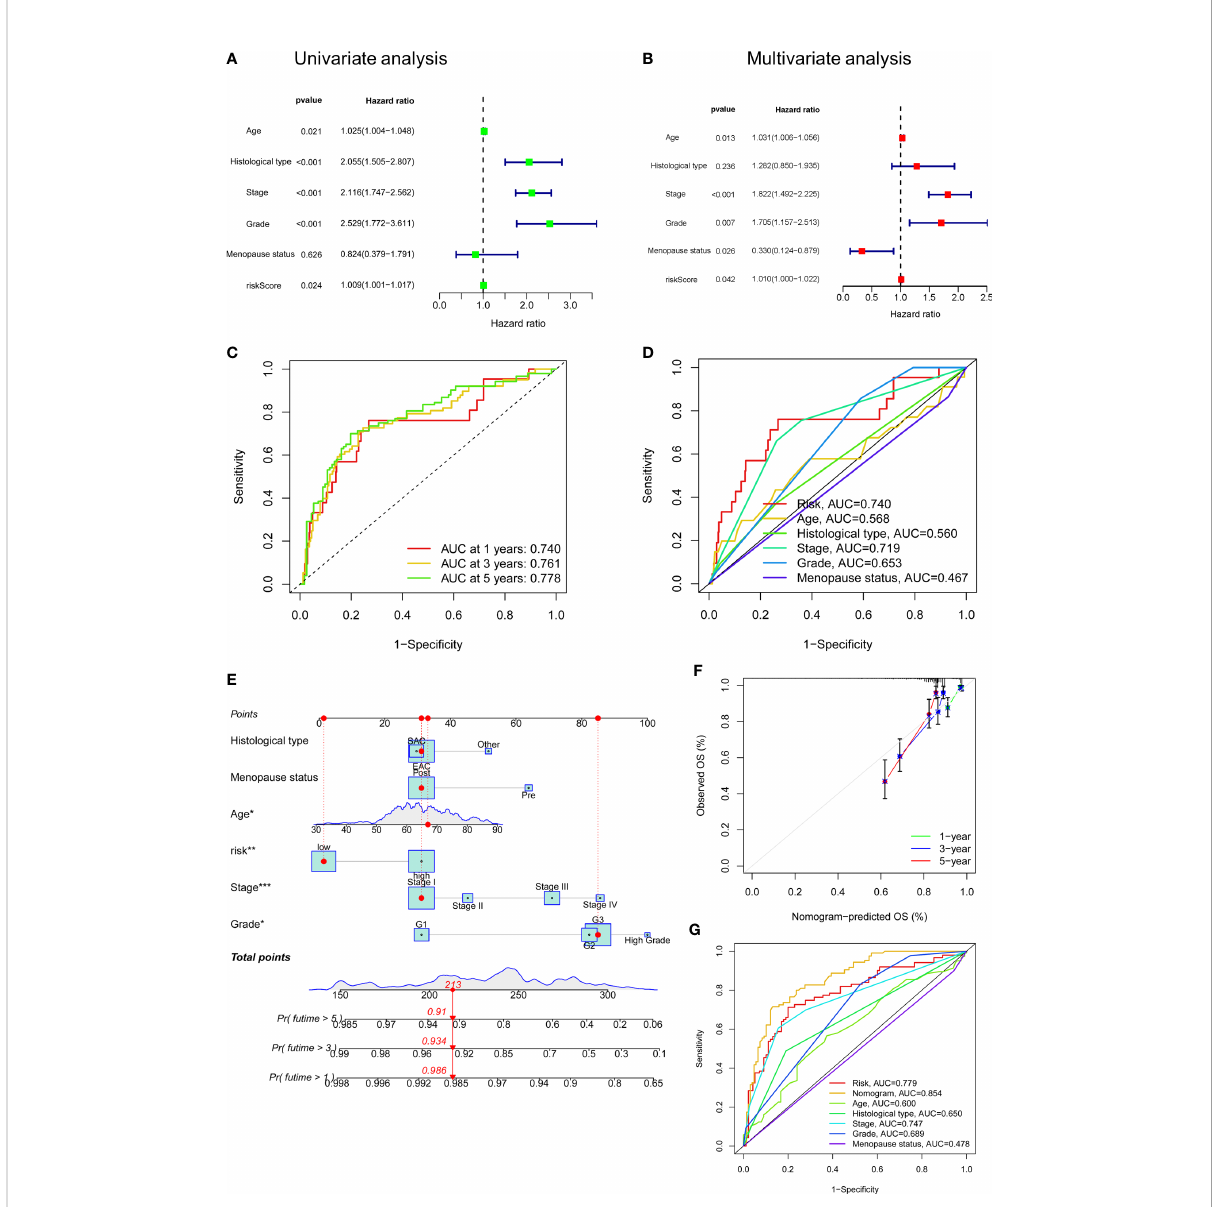
FIGURE 4 Independent prognostic value of risk score and a nomogram construction. (A) Univariate Cox analysis of risk score and clinicopathologic parameters. (B) Multivariate Cox analysis. (C) ROC curve of risk score for 1-, 3- and 5- years ’ OS. (D) ROC curves of risk score, age, histological type, stage, grade, menopause status. (E) A Nomogram consisting of risk score, age, grade, stage, histological type, and menopause status. (F) Calibration curves for patients ’ OS at 1, 2, and 3 years. (G) ROC curves for the nomogram and clinicopathologic factors. ROC: receiver operating characteristic. OS: overall